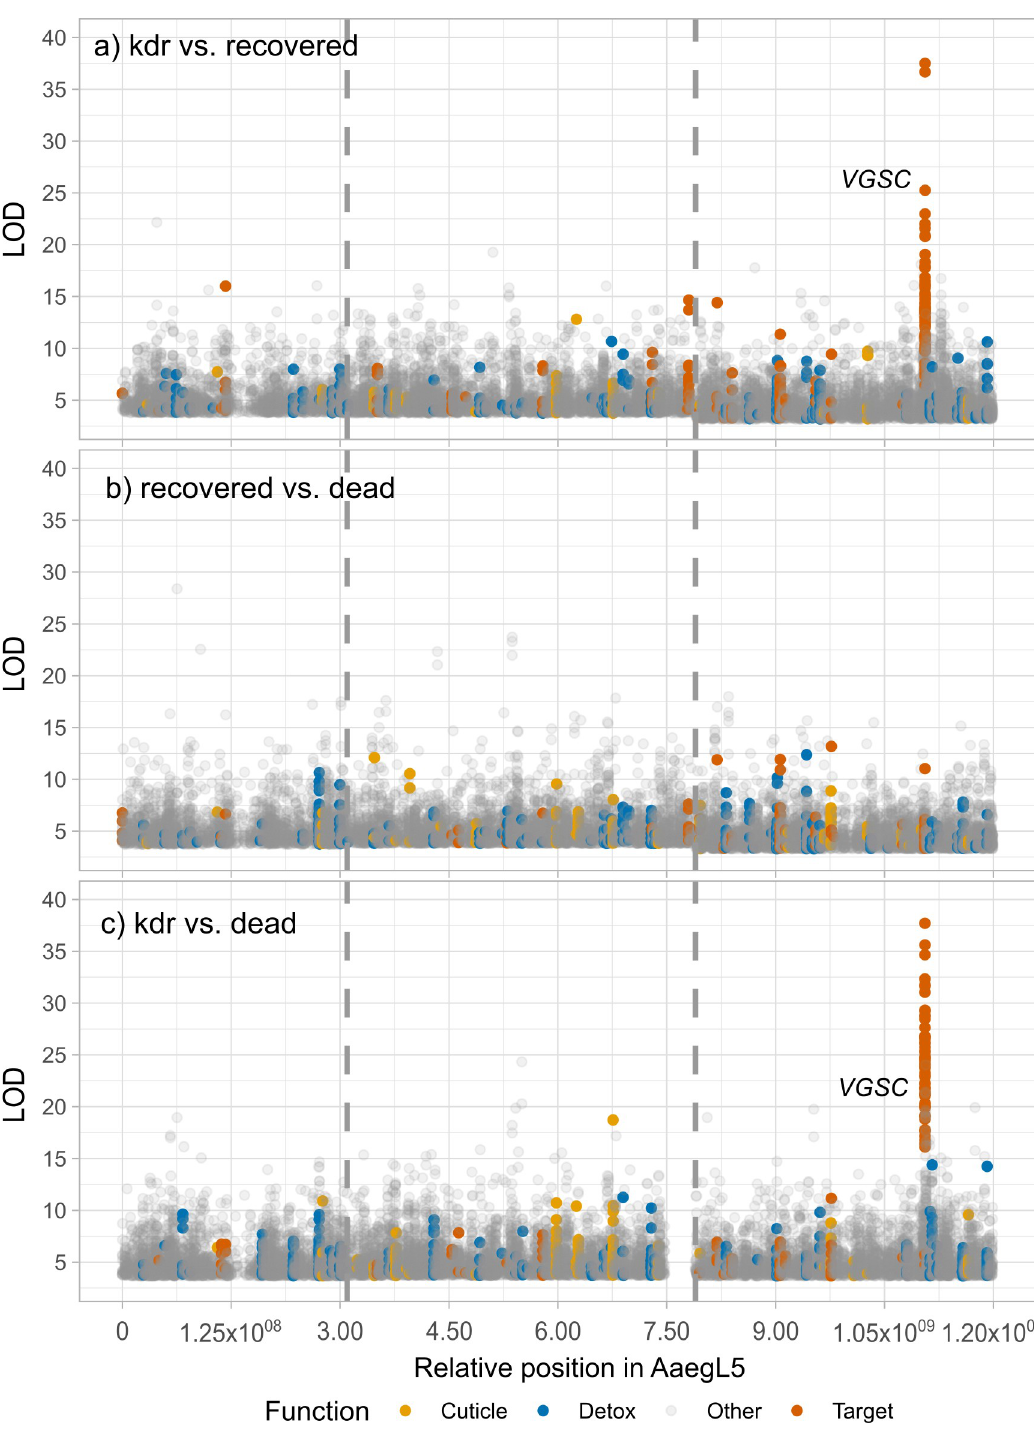
Fig 2. Distribution of SNPs associated with kdr, recovered, and dead Aedes aegypti exposed to permethrin. The relative physical position is based in Ae . aegypti AaegL5 assembly. LODs correspond to the–log 10 ( p value ) obtained in a chi square test that compared the proportion of the alternate allele between pairwise comparisons. A) kdr vs recovered and B) recovered vs dead and C) kdr vs dead. SNPs located in insecticide target site (yellow), detoxification (red), and cuticle genes (green) are highlighted.